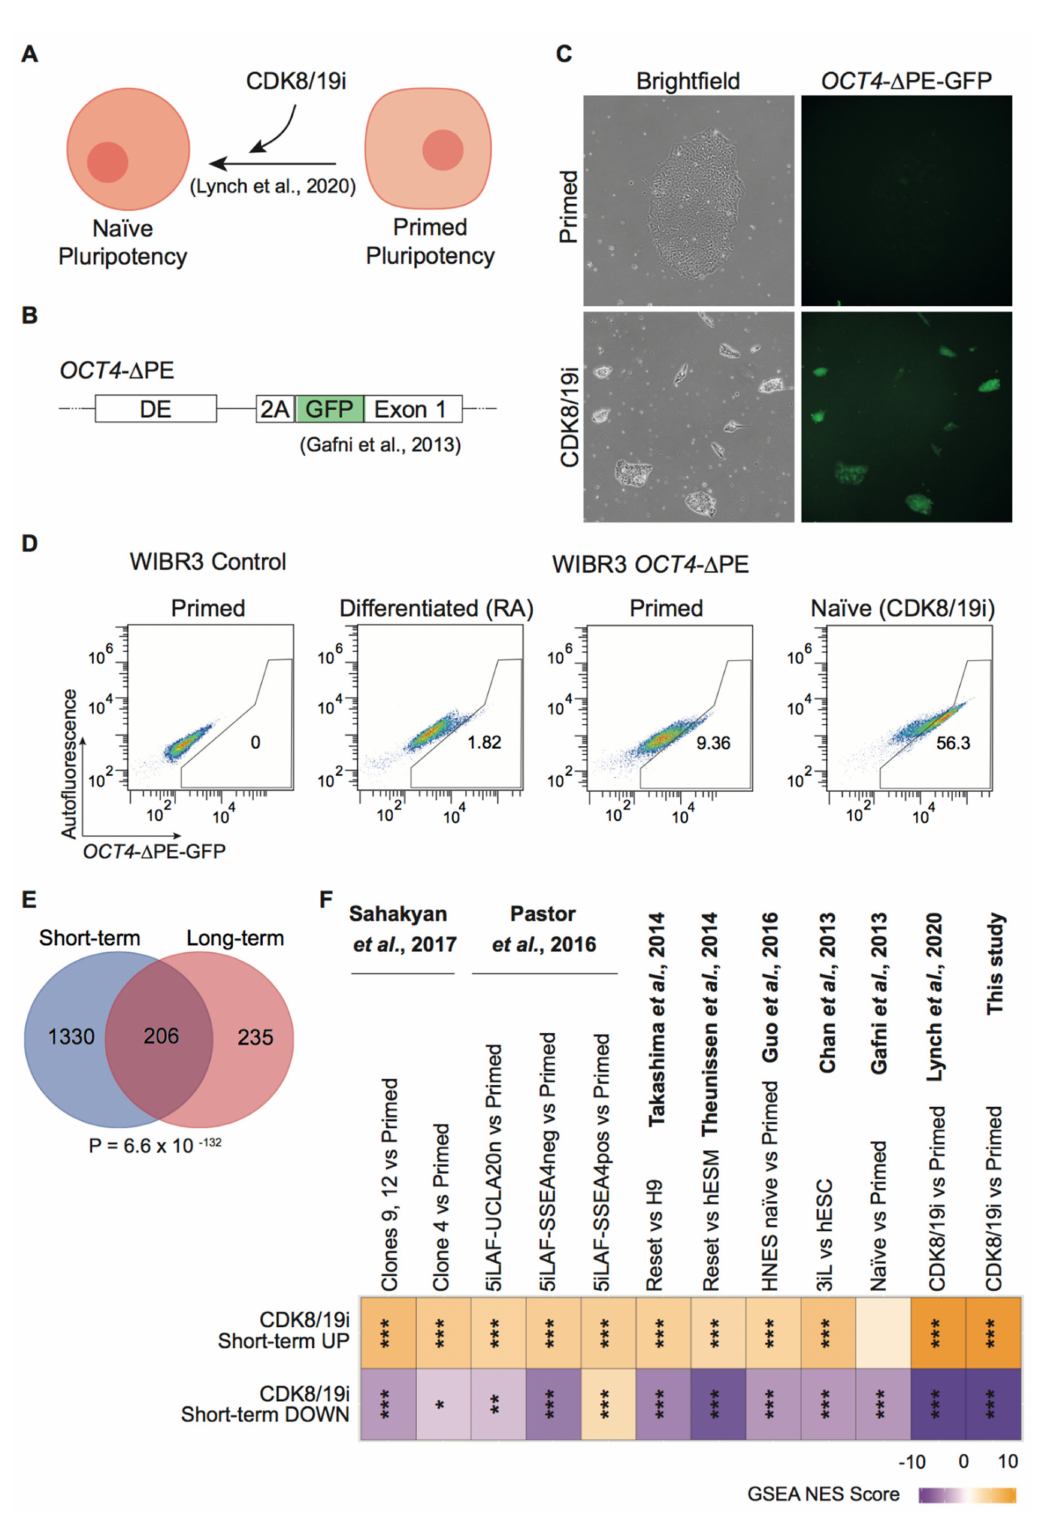
Figure 1. Stability of hPSC-naïve pluripotency after long-term culture with CDK8/19i. ( A ) Experimental scheme for inducing naïve conditions using the previously reported CDK8/19i chemical approach [20]. ( B ) Schematic diagram